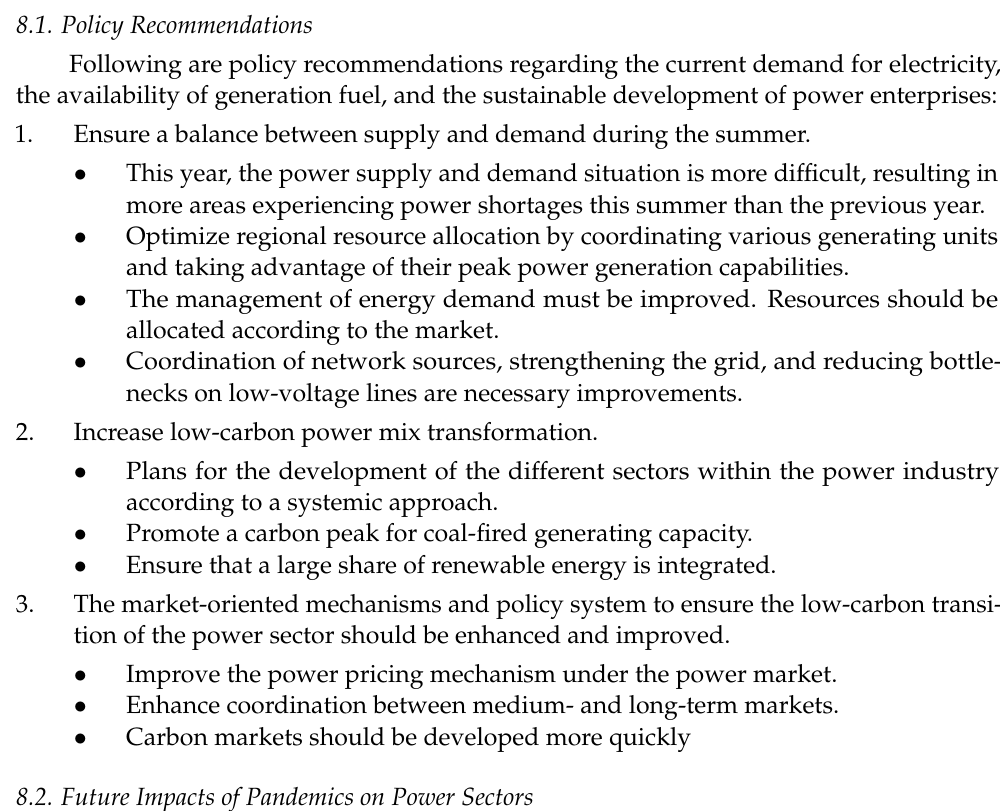
Figure 20. Based on COVID-19, the power sector has several challenges and opportunities.